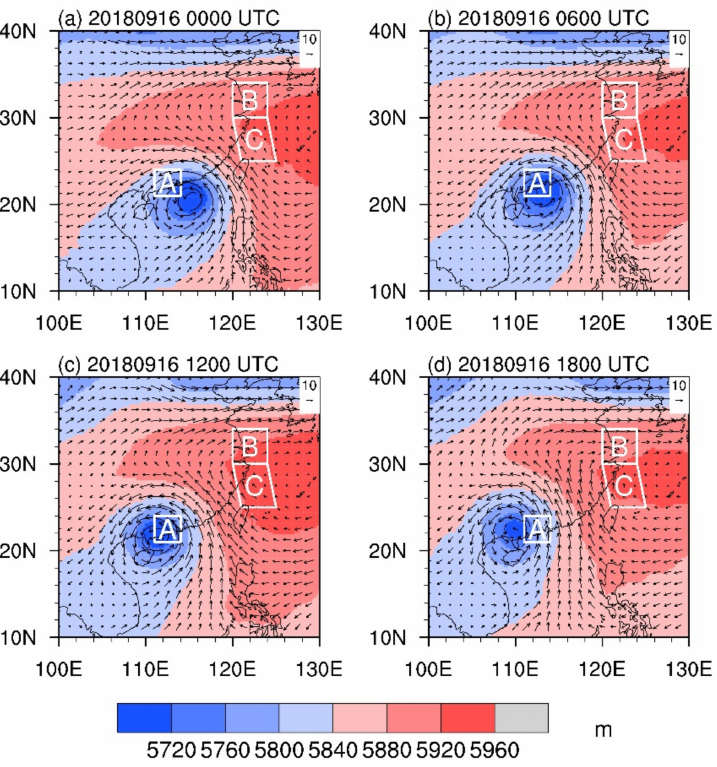
Figure 2. The 500 hPa geopotential height and wind from 0 to 18 UTC on 16 September 2018. ( a ) 0000 16 September, ( b ) 0600 16 September, ( c ) 1200 16 September and ( d ) 1800 16 September. A stands for the Pearl River Delta, B stands for the Yangtze River Delta and C stands for the water vapor transport